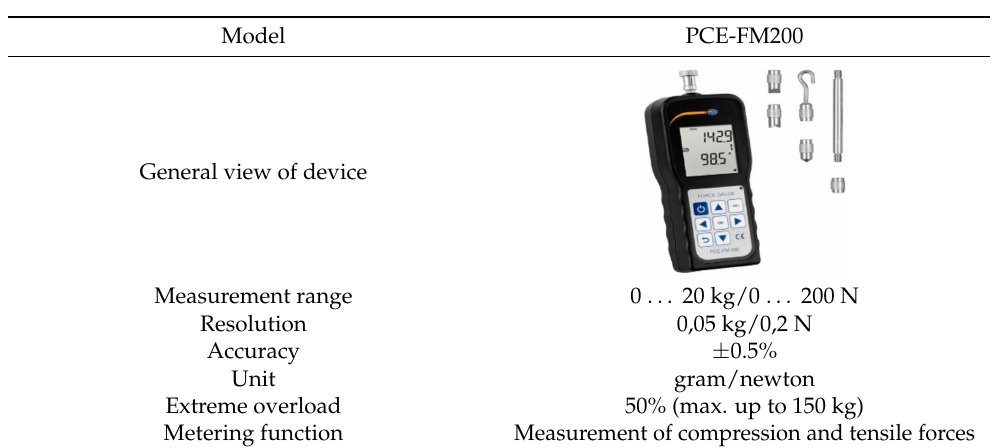
Table 6. Technical characteristics of the